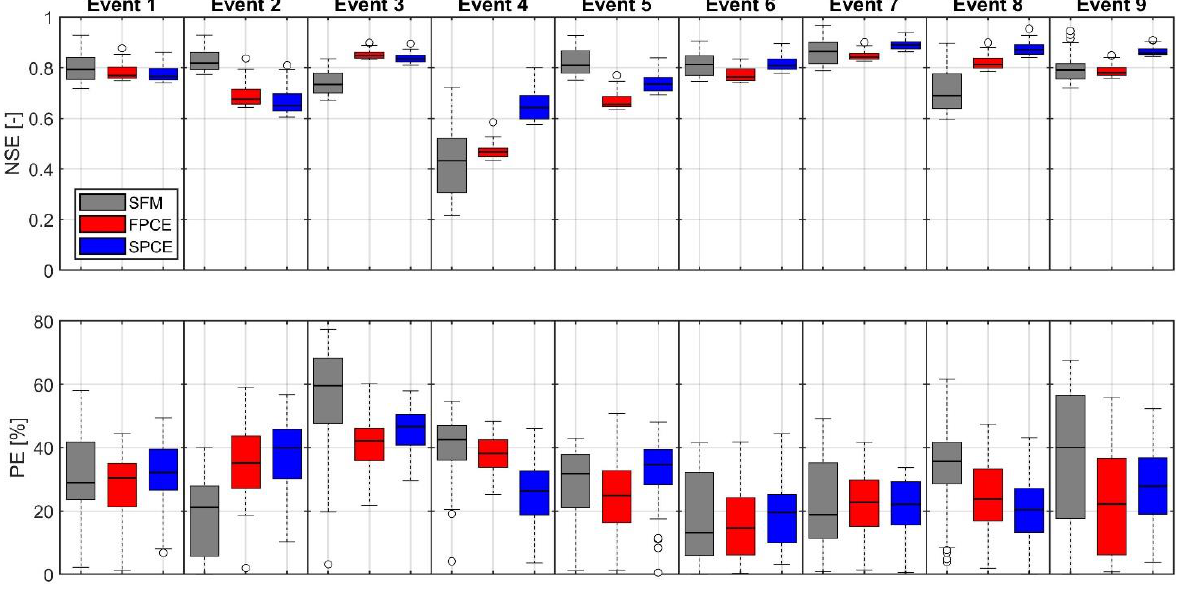
Figure 6. Comparisons of accuracy metrics, NSE and PE for three models (SFM, FPCE, and SPCE) for nine streamflow events. The boxplots demonstrate the median (central mark), the 25th and 75th percentiles (the edges of the box), and the maximum and minimum (the upper and lower whiskers) except for outliers (circle symbols).